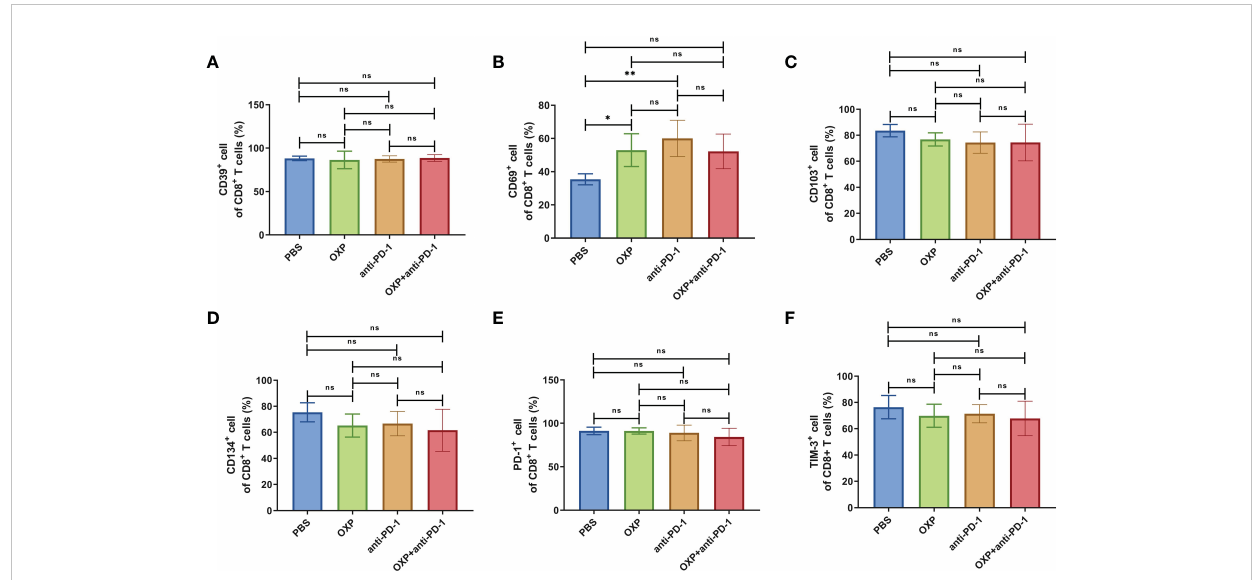
FIGURE 5 The phenotype of CD8 + T cells in TIME. (A) The percentage of CD39 + cells of CD8 + T cells. (B) The percentage of CD69 + cells of CD8 + T cells. (C) The percentage of CD103 + cells of CD8 + T cells. (D) The percentage of CD134 + cells of CD8 + T cells. (E) The percentage of PD-1 + cells of CD8 + T cells. (F) The percentage of TIM-3 + cells of CD8 + T cells. ns P > 0.05, *P < 0.05; **P <